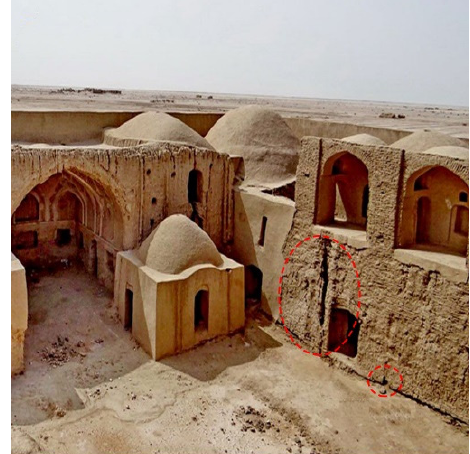
Figure 6. Mochi Castle conservation.